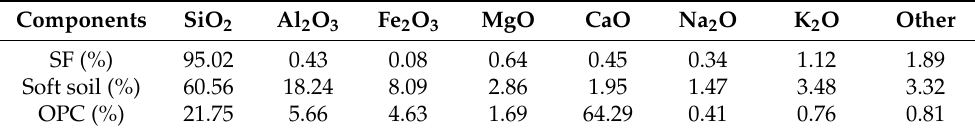
Table 2. Chemical compositions of soft soil, silica fume (SF) and ordinary Portland cement (OPC). Components SiO